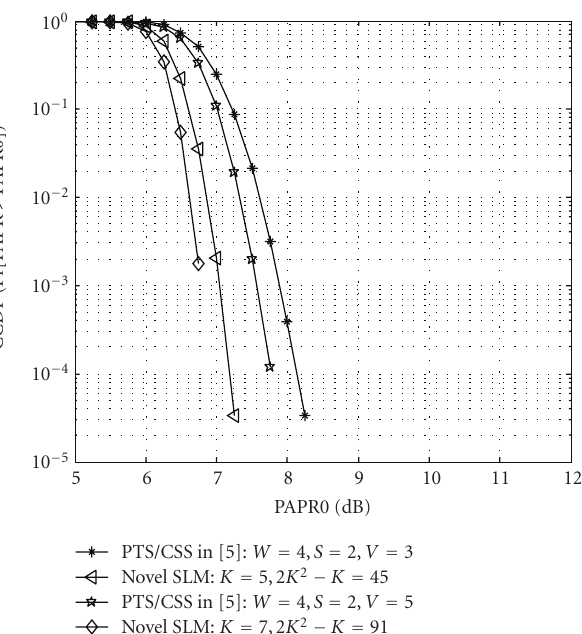
Figure 8: PAPR reduction performance of the novel SLM scheme and the PTS scheme in